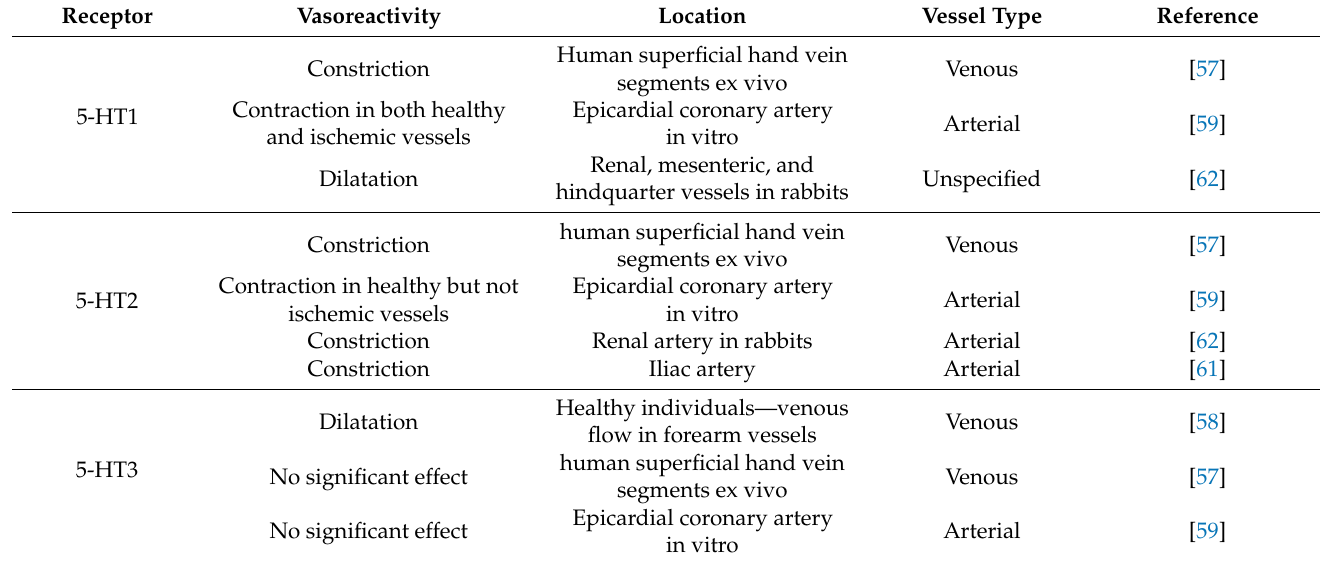
Table 1. Vasoreactivity to